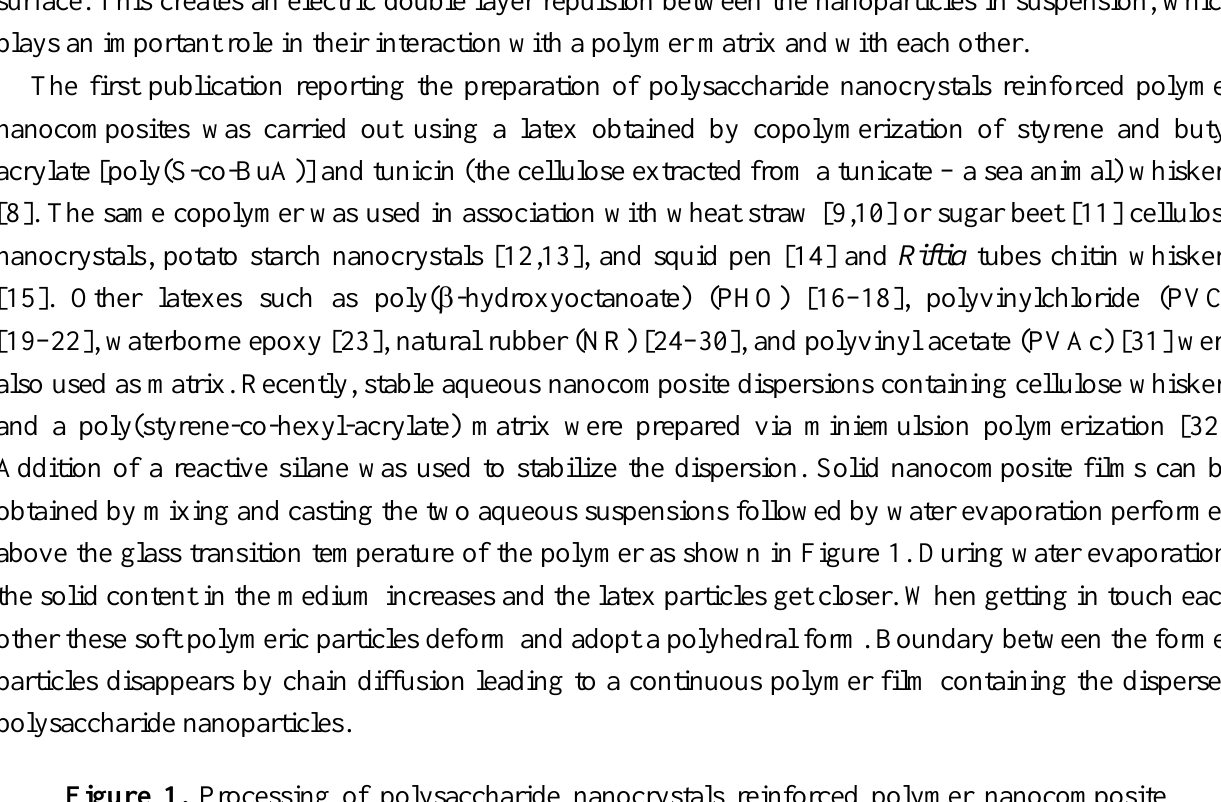
Figure 1. Processing of polysaccharide nanocrystals reinforced polymer nanocomposite films using polymer